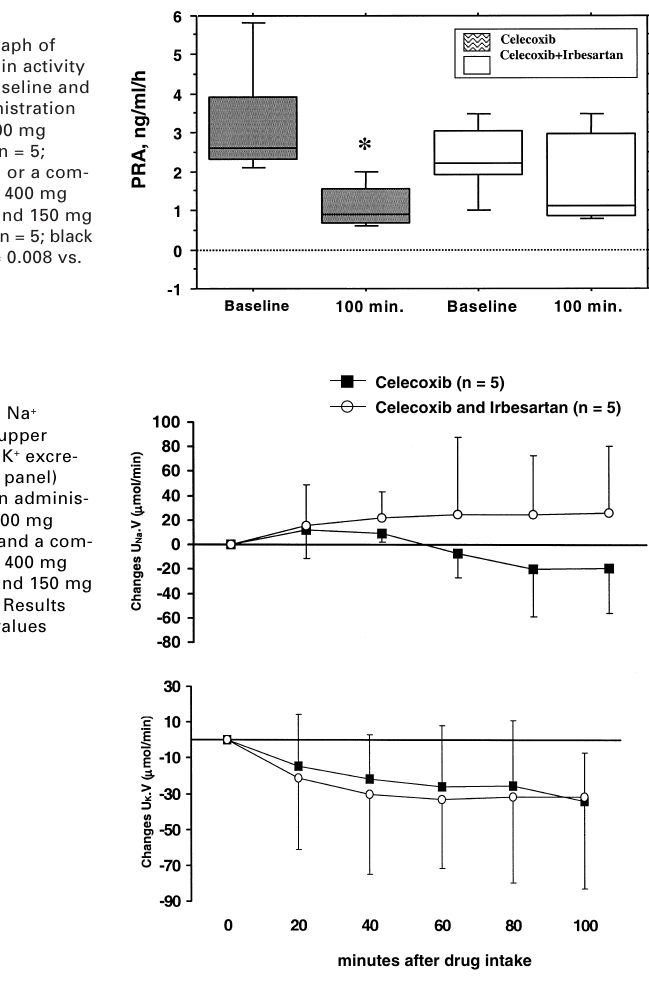
(Table 1). In Figure 1, the results of GFR and ERPF are depicted as relative changes versus baseline.